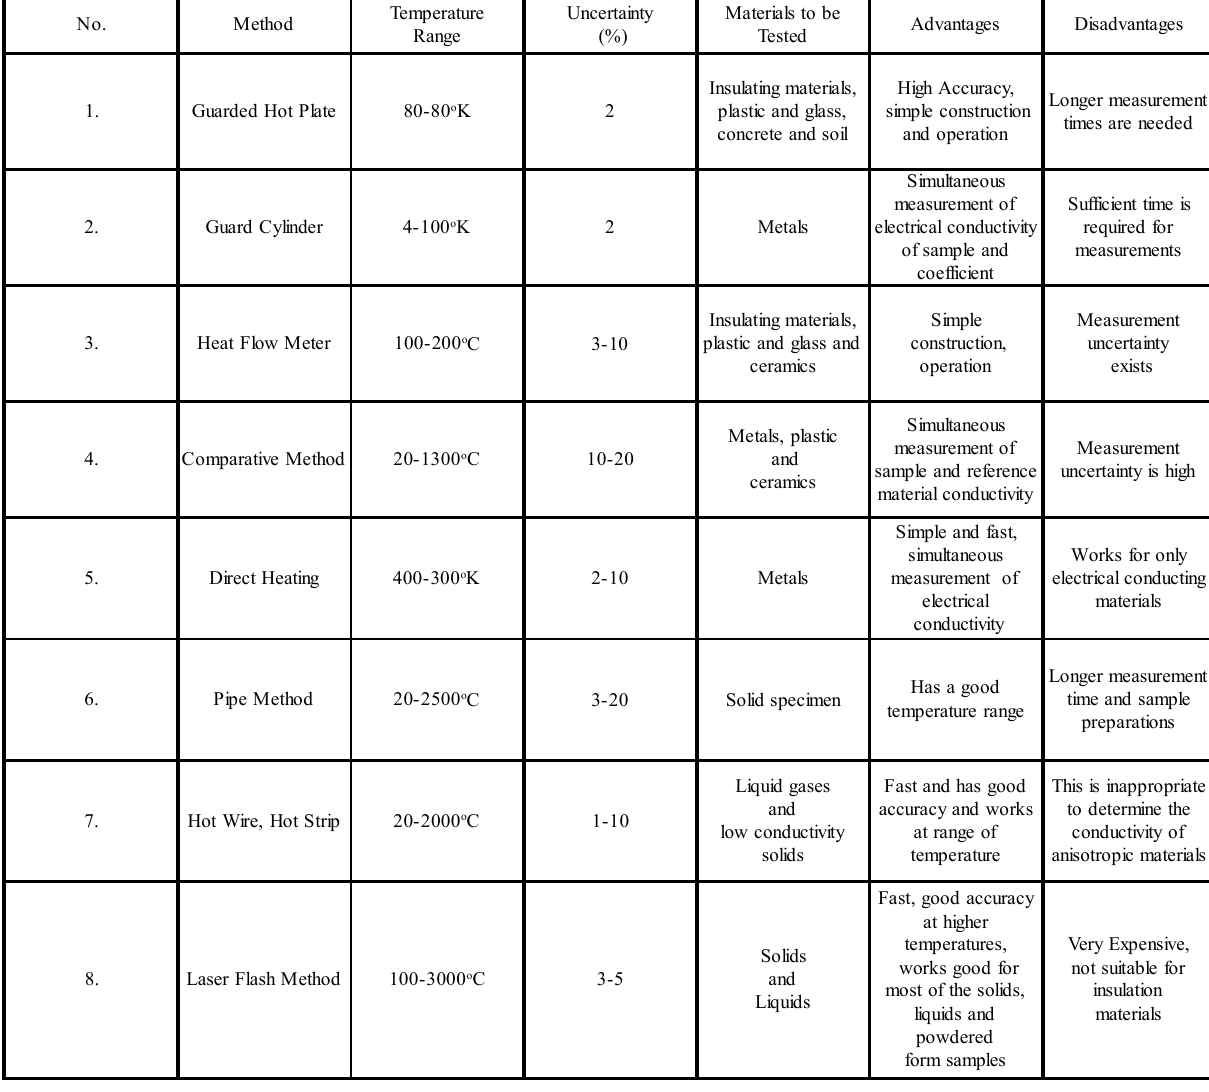
TABLE 1. COMPARISON OF ALL THERMAL CONDUCTIVITY MEASUREMENTS METHODS AND THEIR LIMITA TIONS